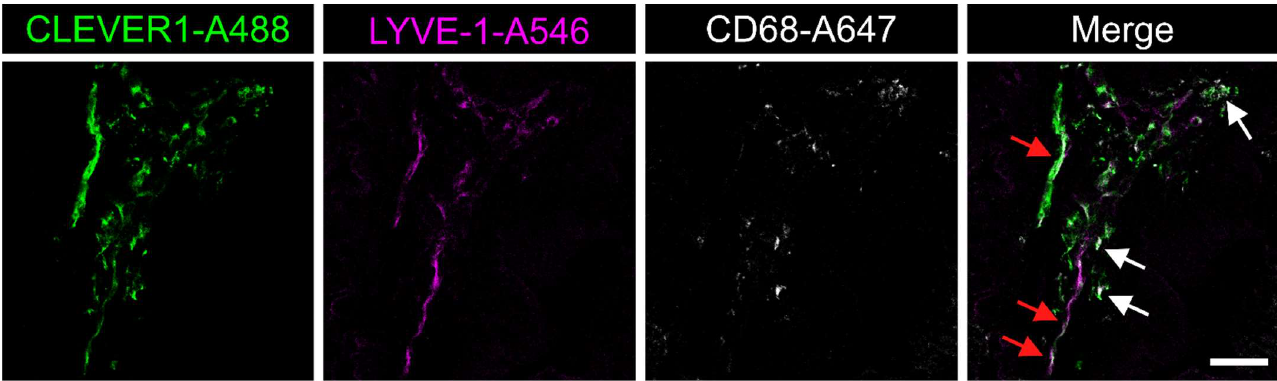
Figure 4. Immunofluorescence staining of CLEVER-1 + /CD68 + macrophages and CLEVER-1 + lymphatic vessels in a fresh frozen colorectal cancer sample. White arrows show CLEVER-1 + /CD68 + macrophages, whereas red arrows mark LYVE-1 + lymphatic vessels positive for CLEVER-1. Scale bar 50 µm.